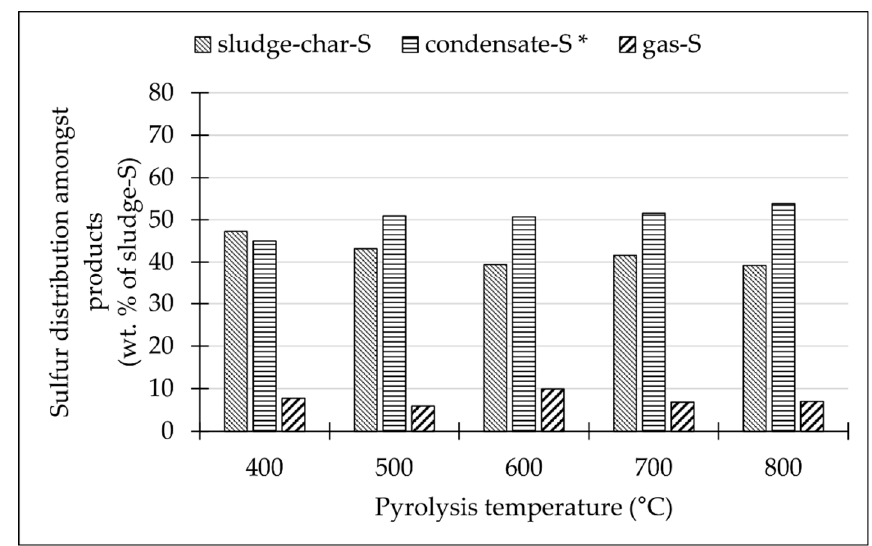
Figure 3. Sulfur distribution amongst sludge pyrolysis products (*—determined by difference), Adapted from Moško et al. [25].